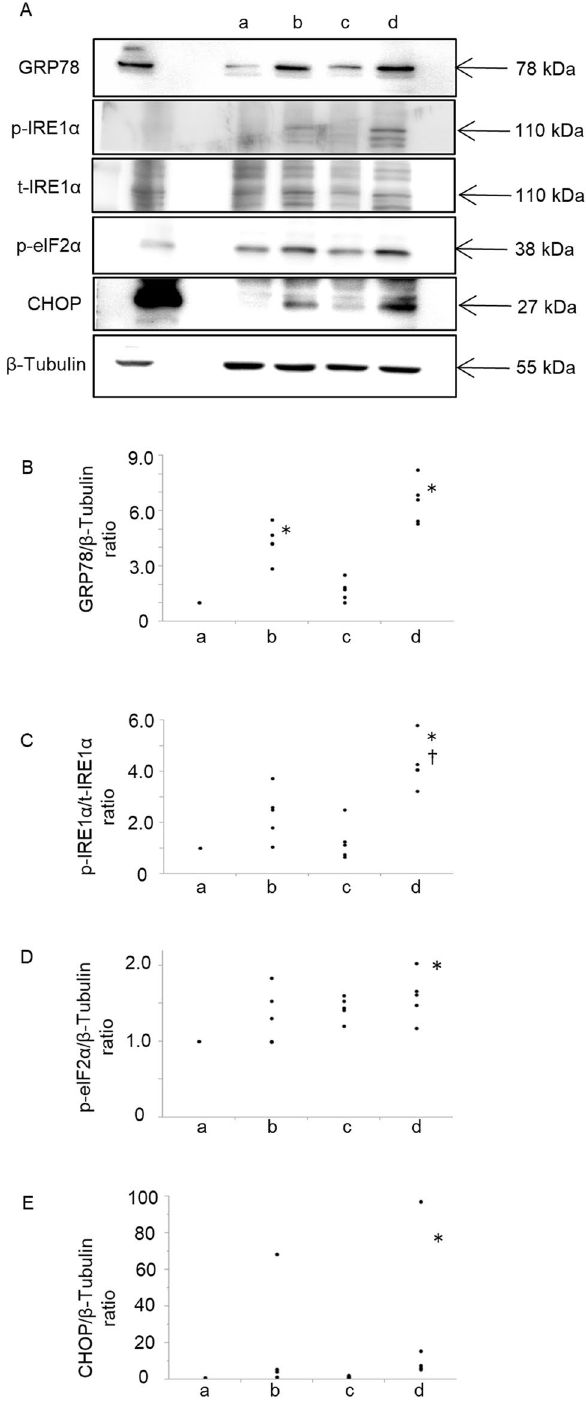
Figure 4. Synergic induction of endoplasmic reticulum (ER) stress by homocysteine and cigarette smoke extract (CSE) in A549 cells. To examine the impact of simultaneous stimulation of homocysteine and CSE on the ER stress, A549 cells were treated with 20% CSE and 5 mM homocysteine, and then the protein levels of GRP78, phosphorylation of IRE1α and p-eIF2α, protein level of CHOP was examined using western blotting. ( A ) Graphic depictions of western blotting. ( B – E ) Quantitative analysis for protein expression of GRP78, phosphorylation of IRE1α, phosphorylation of eIF2α, protein expression of CHOP by western blotting. The protein expression level of GRP78 ( B ) was significantly elevated in response to homocysteine stimulation. The protein expression levels of GRP78 ( B ), phosphorylation of IRE1α ( C ), and protein expression levels of p-eIF2α ( D ) and CHOP ( E ) were significantly elevated in response to the combined stimulation of homocysteine and CSE compared to control. a; control, b; homocysteine 5 mM, c; 20% CSE, d; homocysteine 5 mM + 20% CSE. n = 5 in each group. Differences between groups were examined using Bonferroni/Dunn test. *P < 0.05 vs homocysteine 0 mM, † P < 0.05 vs 20% CSE. CSE cigarette smoke extract, CHOP CCAAT/enhancer binding protein homologous protein, GRP78 78-kDa glucose-regulated protein, p-IRE1α phosphorylation of inositol-requiring enzyme 1α, p-eIF2α phosphorylate eukaryotic translation initiation factor